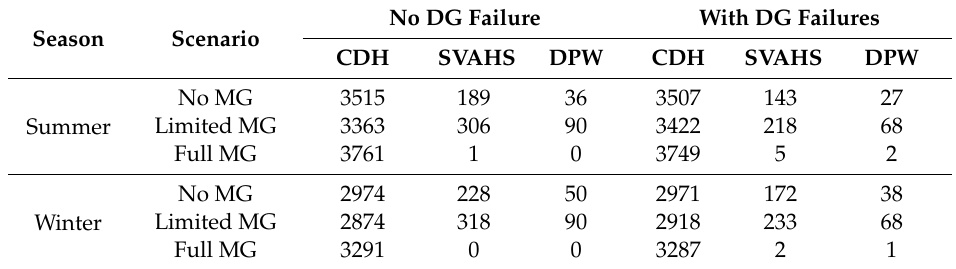
Table 14. Mean diesel fuel consumption (gallons) of the system without CDH PV in 3 days